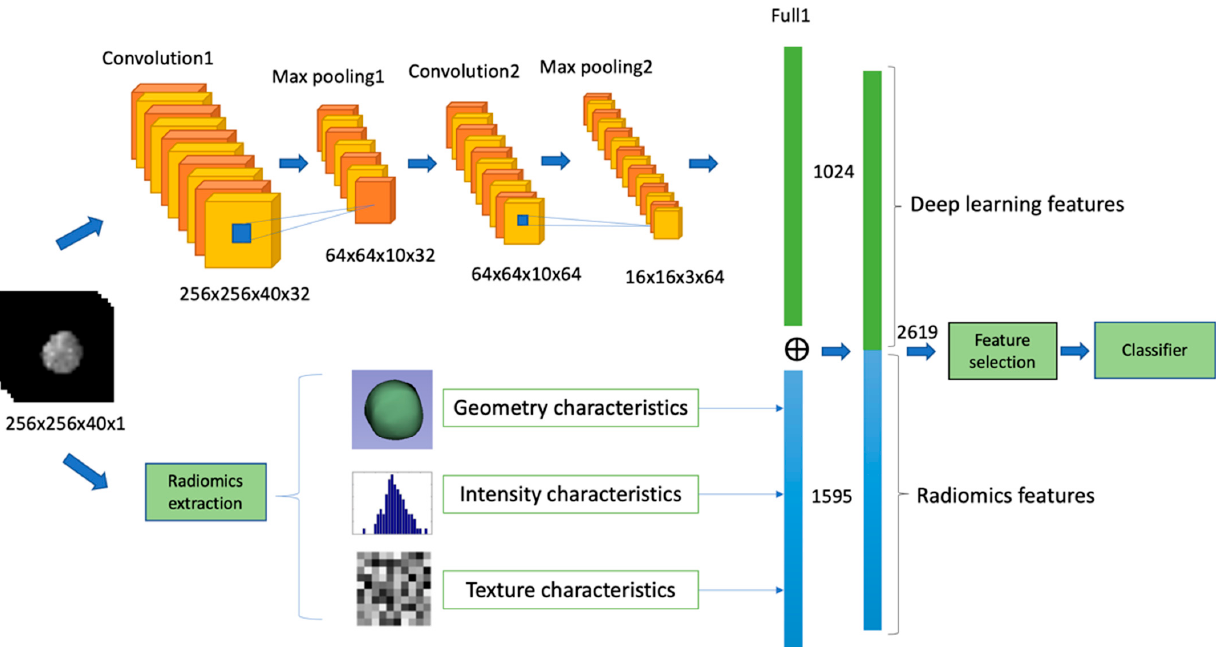
Figure 2. The predictive models from the integration of radiomics and deep features.